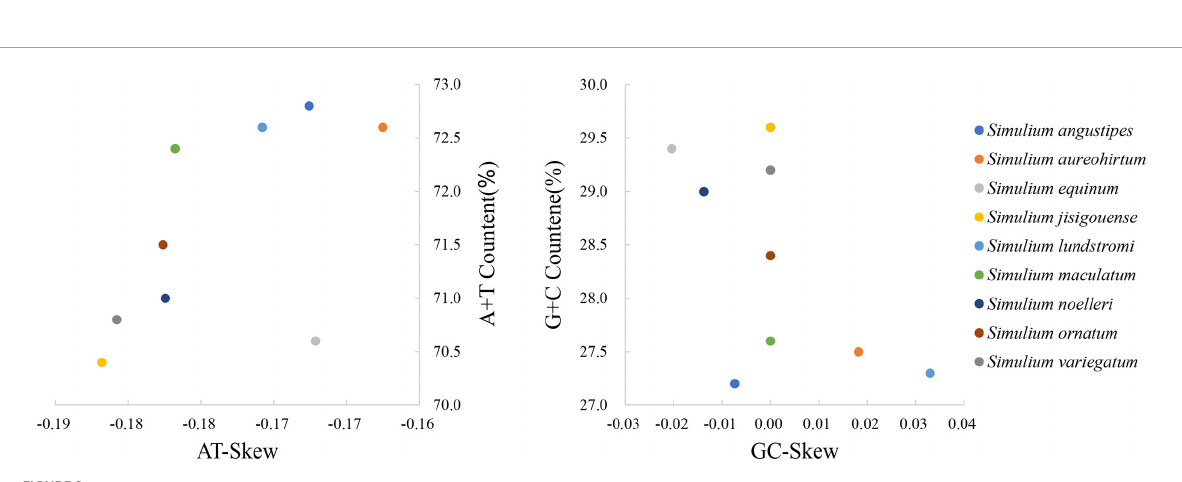
FIGURE2 AT% vs. AT-Skew and GC% vs. GC-Skew in Simuliidae mitogenomes of